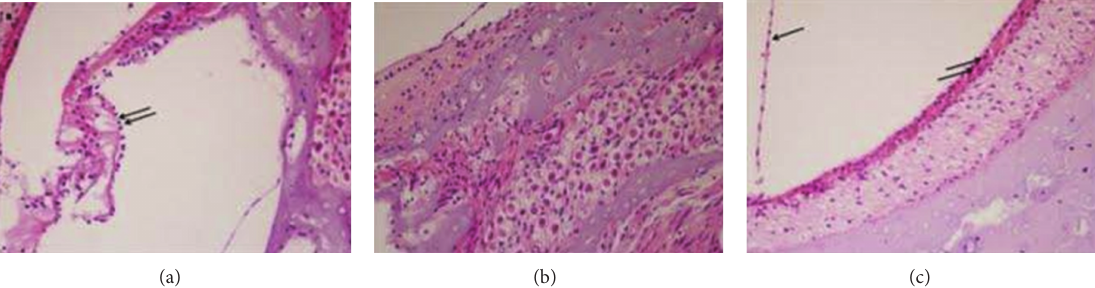
Figure 3: Showing the OHCs comparable to the control group ( ↑↑ ). (b) Showing spiral ganglion cells without destruction. (c) Showing apparently normal stria vascularis ( ↑↑ ) and Reissner’s membrane ( ↑ ) as compared with the control group.